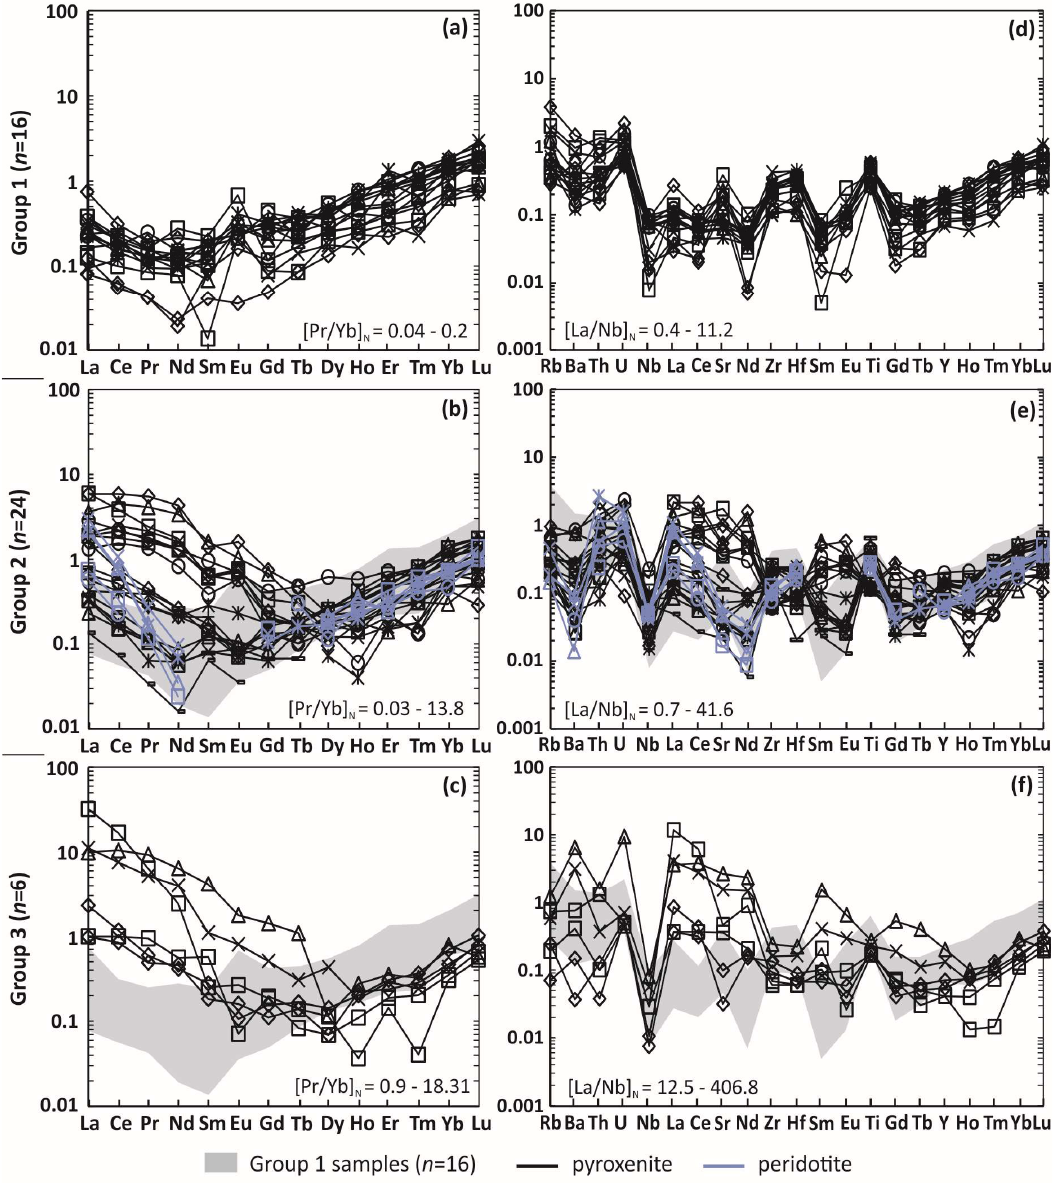
Figure 11. Chondrite-normalised REE ( a – c ) and primitive mantle-normalised [88] trace-element plots ( d – f ) for orthopyroxene grains.